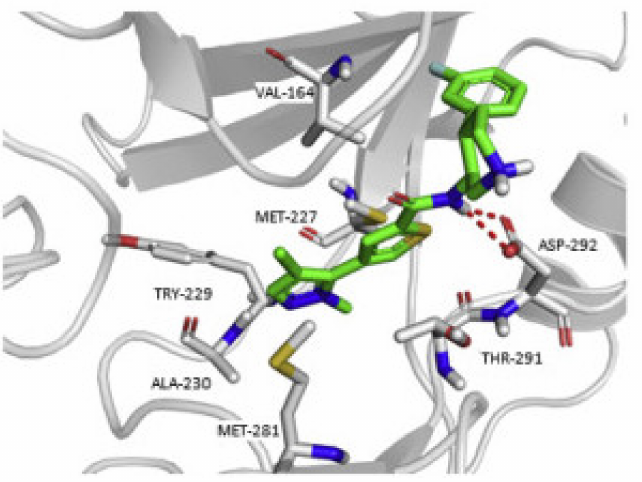
Figure 6. In silico binding interactions of compound 2 with Akt1 kinase crystal structure